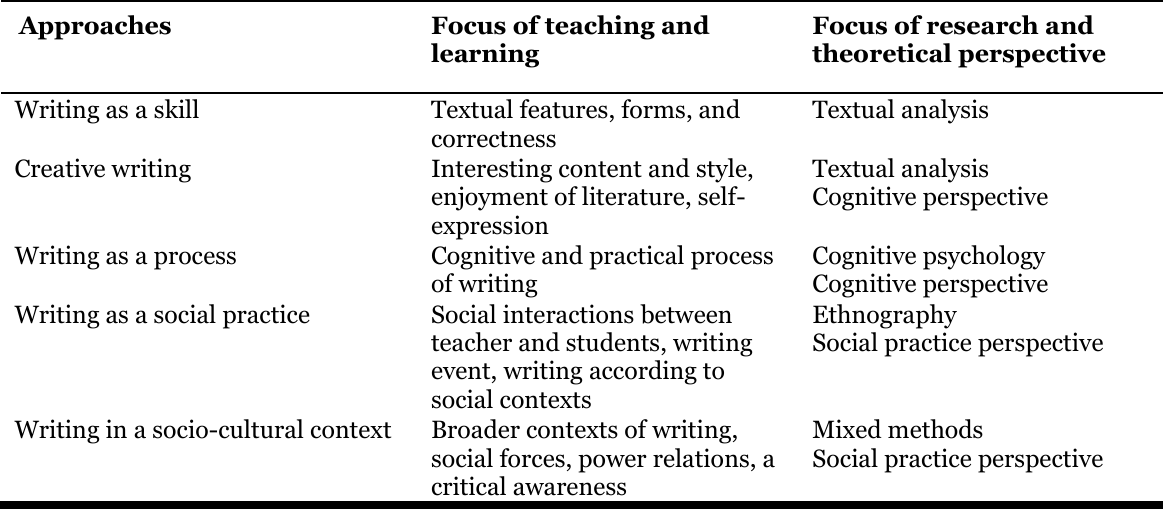
Revised Conceptual Framework for Writing